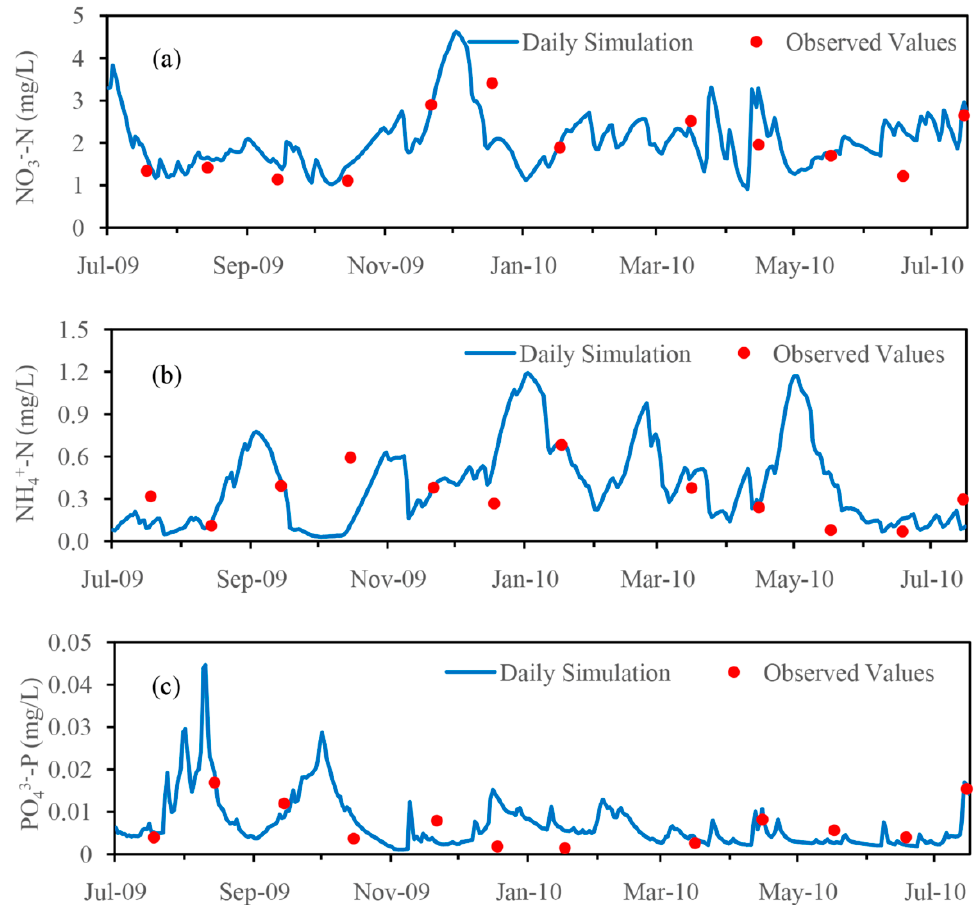
Figure 8. Comparison of the simulated and observed nutrient concentrations for the validation at the Ancheng Bridge station (July 2009–July 2010). ( a ) NO 3 − -N; ( b ) NH 4+ -N; ( c ) PO 43 − -P.